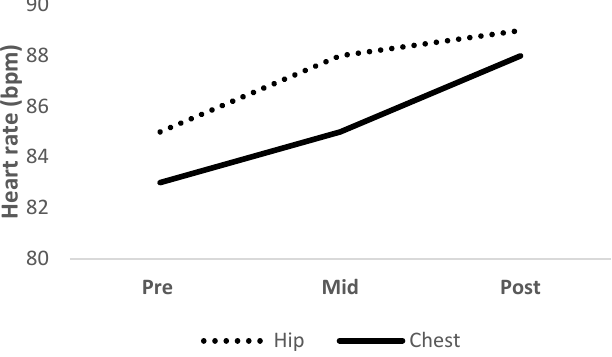
Figure 4. Heart rates measured at pre-, mid-, and post-intervention with the elastic band placed at the hip (dotted line) and chest (solid line).